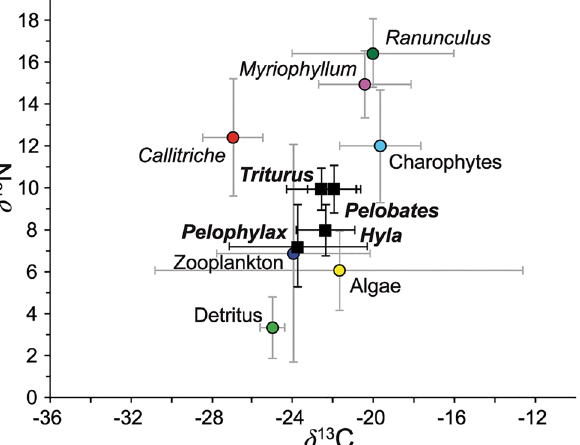
Fig 1. Stable isotope biplot of each amphibian species and sources of the experiment. δ 15 N and δ 13 C values (mean ‰ ± SD) of the amphibians included in this study ( Hyla meridionalis , Pelobates cultripes , Pelophylax perezi , and Triturus pygmaeus ) pooled across all experimental treatments for a general view of differences in trophic status among species. Resources are also shown as means ± SD. The discrimination factors were added to the sources and not subtracted to the consumers to allow different discrimination factors to be assigned to different sources.